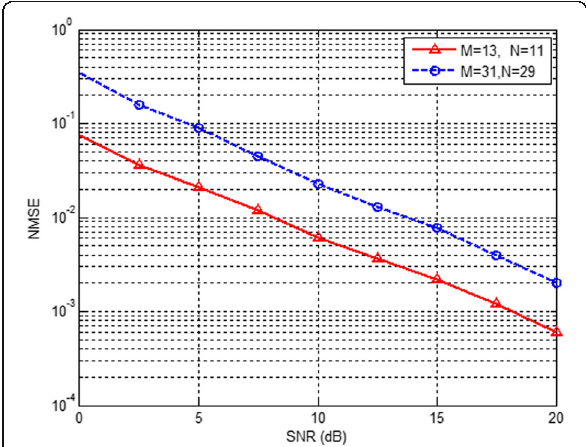
Fig. 8 The NMSE versus SNR under two co-prime with different element numbers. The figure compares the performance of channel estimation in a multi-element array with different array